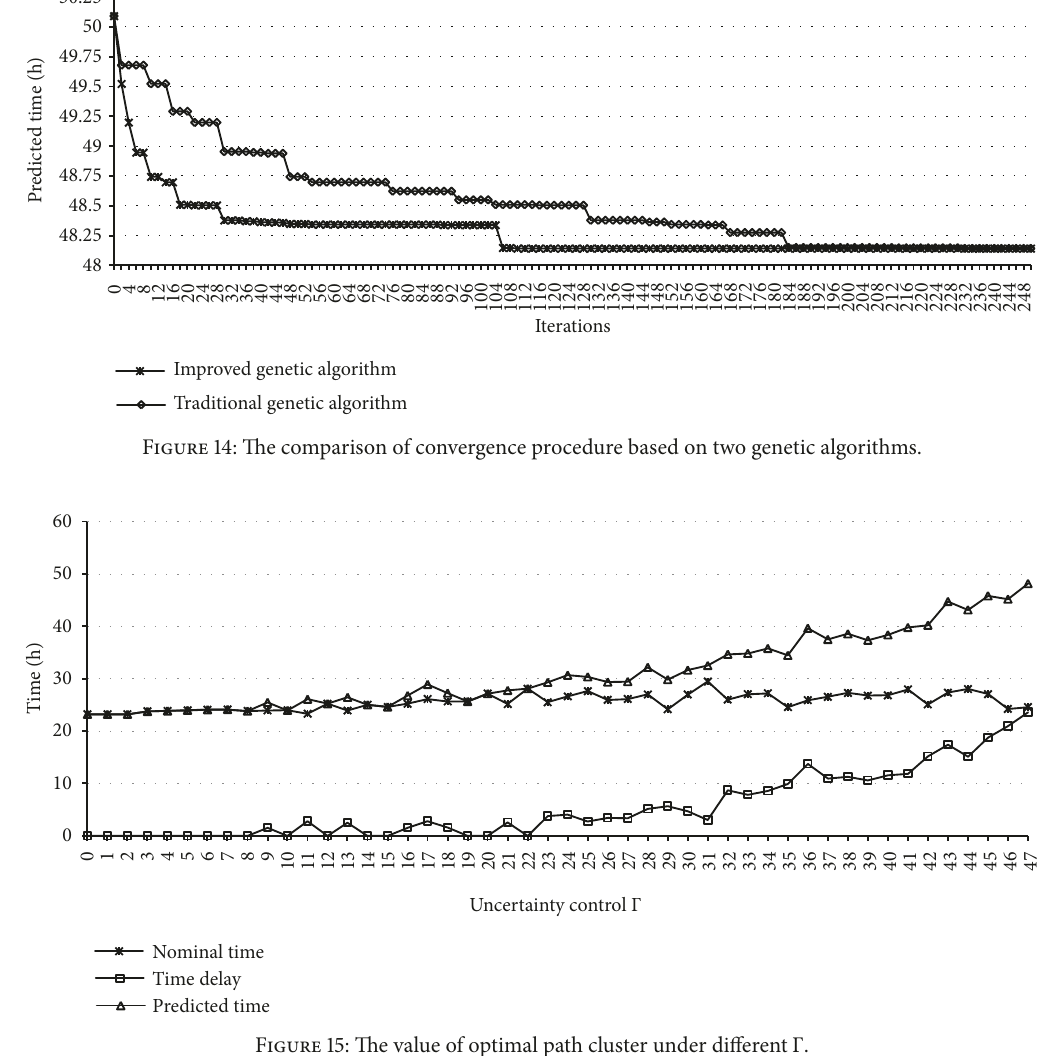
Figure 15: The value of optimal path cluster under different Γ